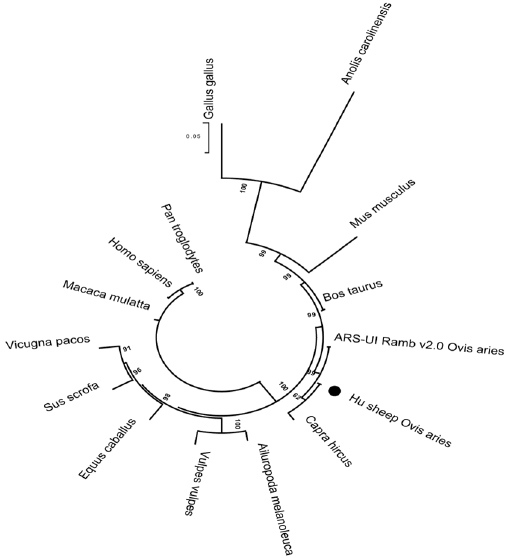
Figure 7. Phylogenetic analysis of the ARNT protein.